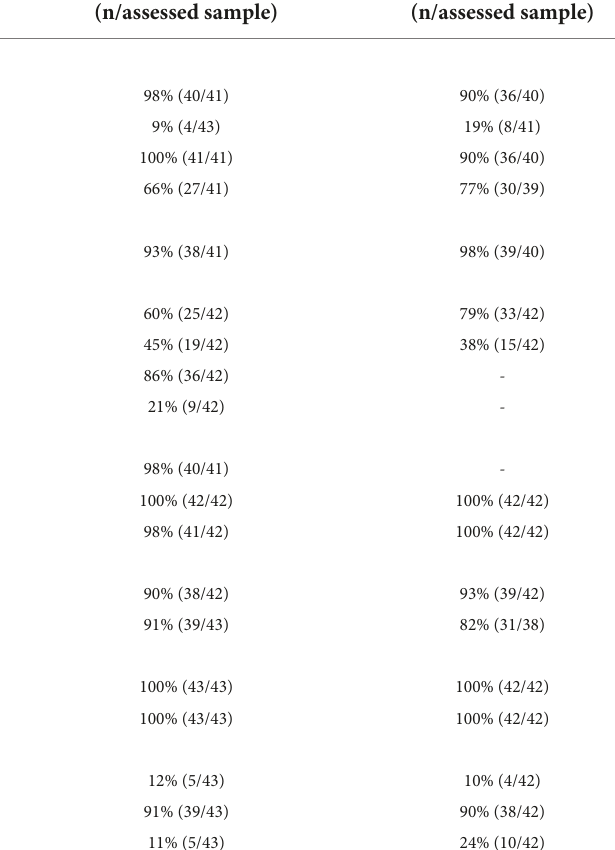
TABLE 7 Final therapy evaluation.